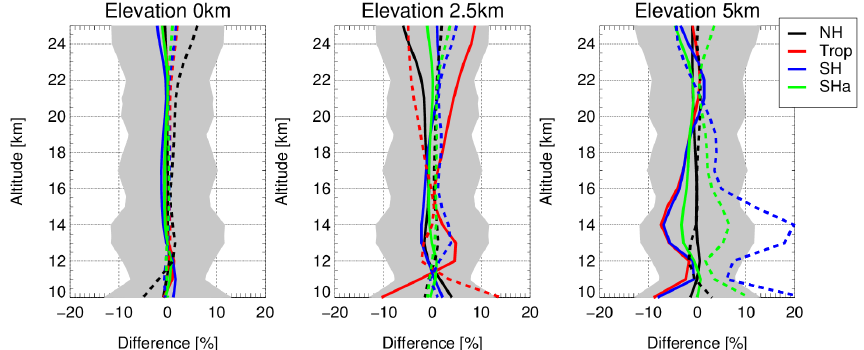
Figure 4. End-to-end test for a perturbed albedo and effective elevation. The comparison is done in a similar manner to Fig. 3 for an albedo of 0.1 (solid lines) and 0.7 (dashed lines). The different surface elevations (0, 2.5, and 5km) are shown in the different panels. The colours mark observation geometries for different regions (NH and SH mid-latitudes, tropics and SH polar regions). The smoothing with the AVK is done for all cases (but has no effect here). The grey shading shows the maximum of retrieval